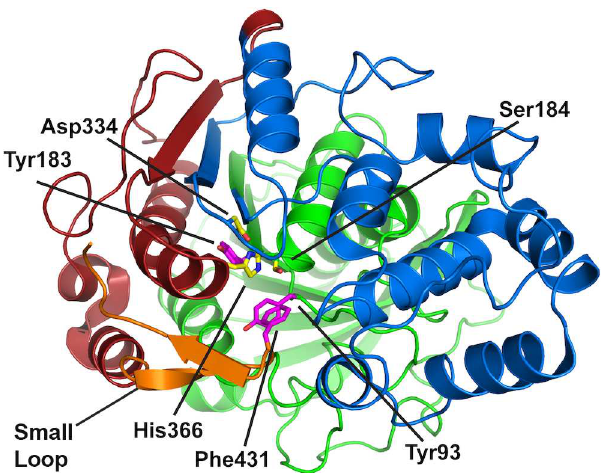
Fig 1. Breakdown of Cal-A into three parts for independent mutagenesis. Shownin cartoon representation with the catalytic triad (Ser184, Asp334, His366; yellow sticks) and key residues (Tyr93, Tyr183 and Phe 431; purplesticks). PART 1 ( N -terminal region11–210,in green) is comprisedof the α / β fold and includesTyr93 and Tyr183. PART 2 (tunnel regionfrom 211–350, in blue) has been hypothesized to bind the substrate[25]. PART 3 (from 351 to C -terminal His-tag, in red) containsthe small loop (in orange),with Phe 431 that may act as a gate-keeping residue. (PDB identificationcode: